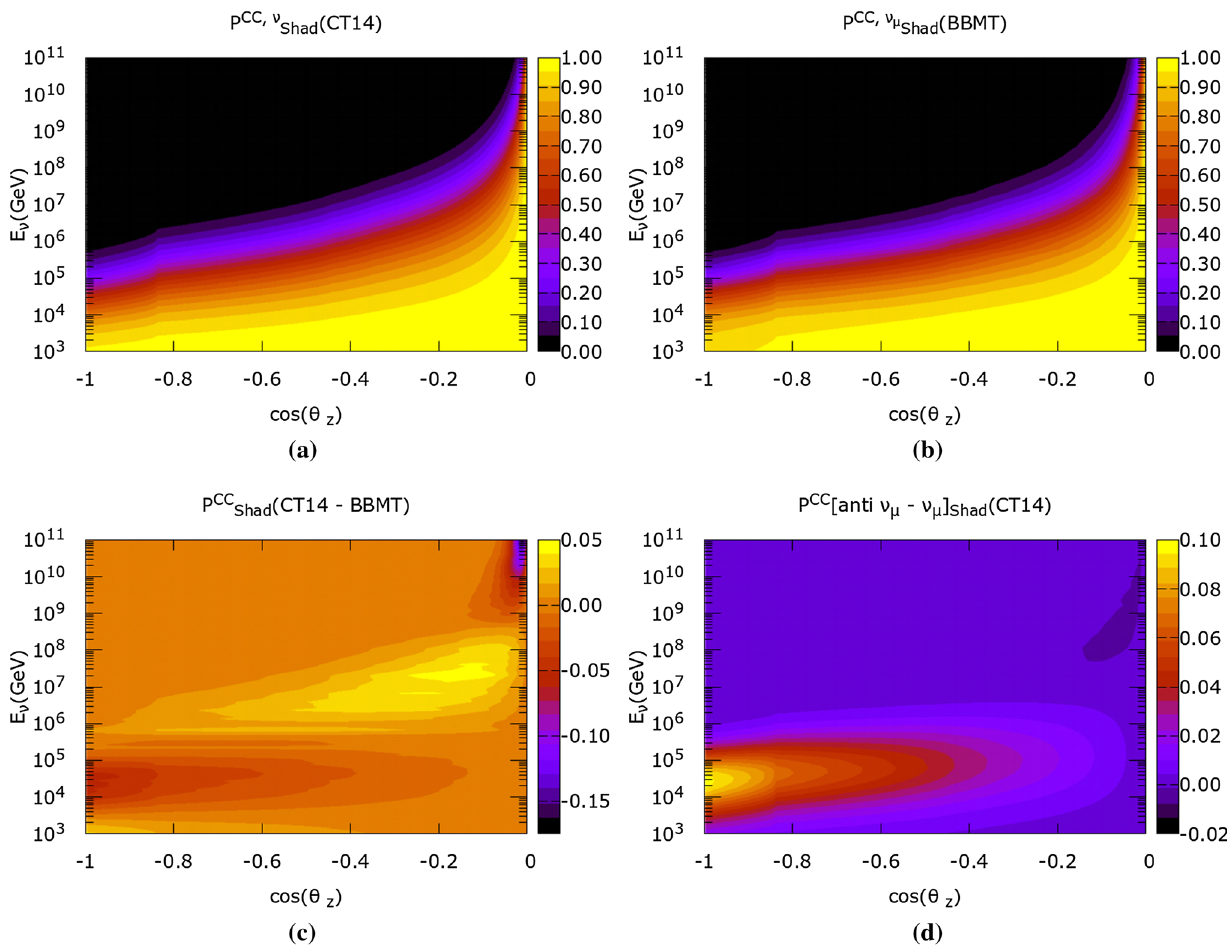
Fig. 7 The energy and angular dependencies of the probability of neu- trino absorption by the Earth, P shad ( E ν ,θ z ) , with σ ν N calculated using the a DGLAP (CT14) approach and the b BBMT model; c Difference